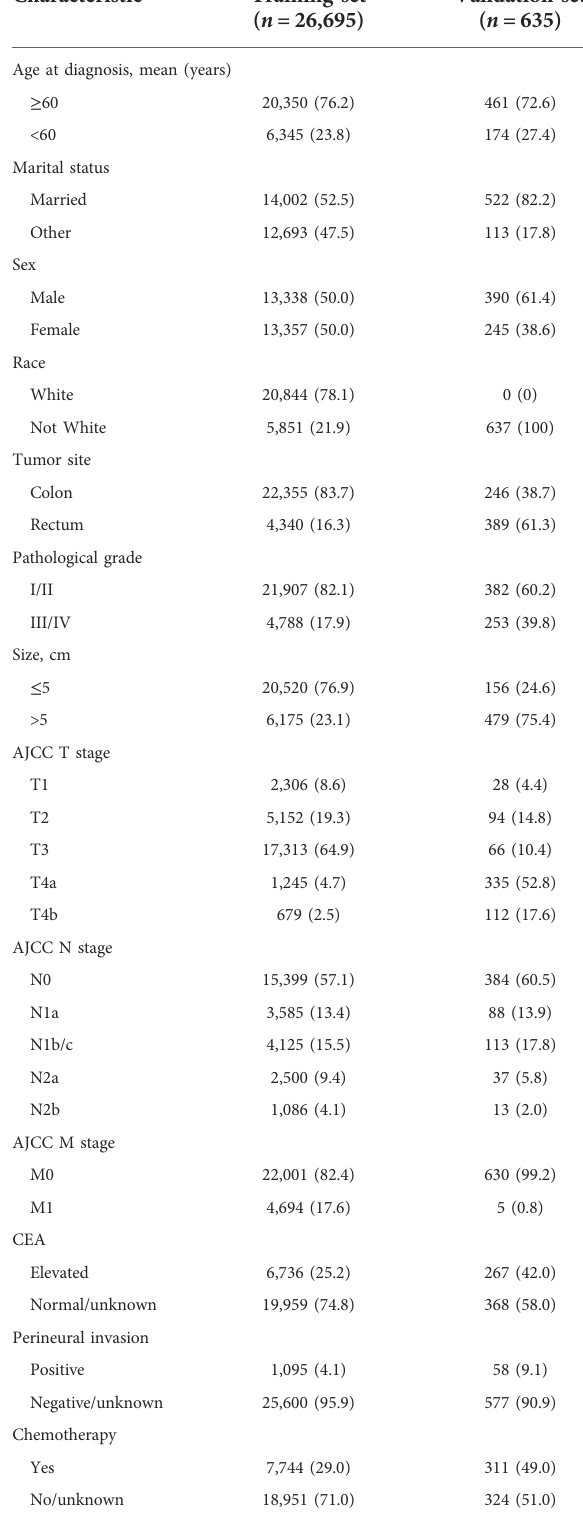
TABLE 1 The demographic and clinical data of all patients.